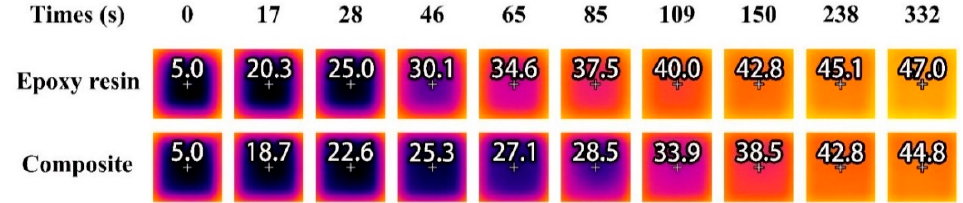
Figure 12. Thermal images of the square sheets of pure epoxy resin and the epoxy composite filled with 20 wt% MicroPCMs. The temperatures at the white cross were marked on the thermal images.